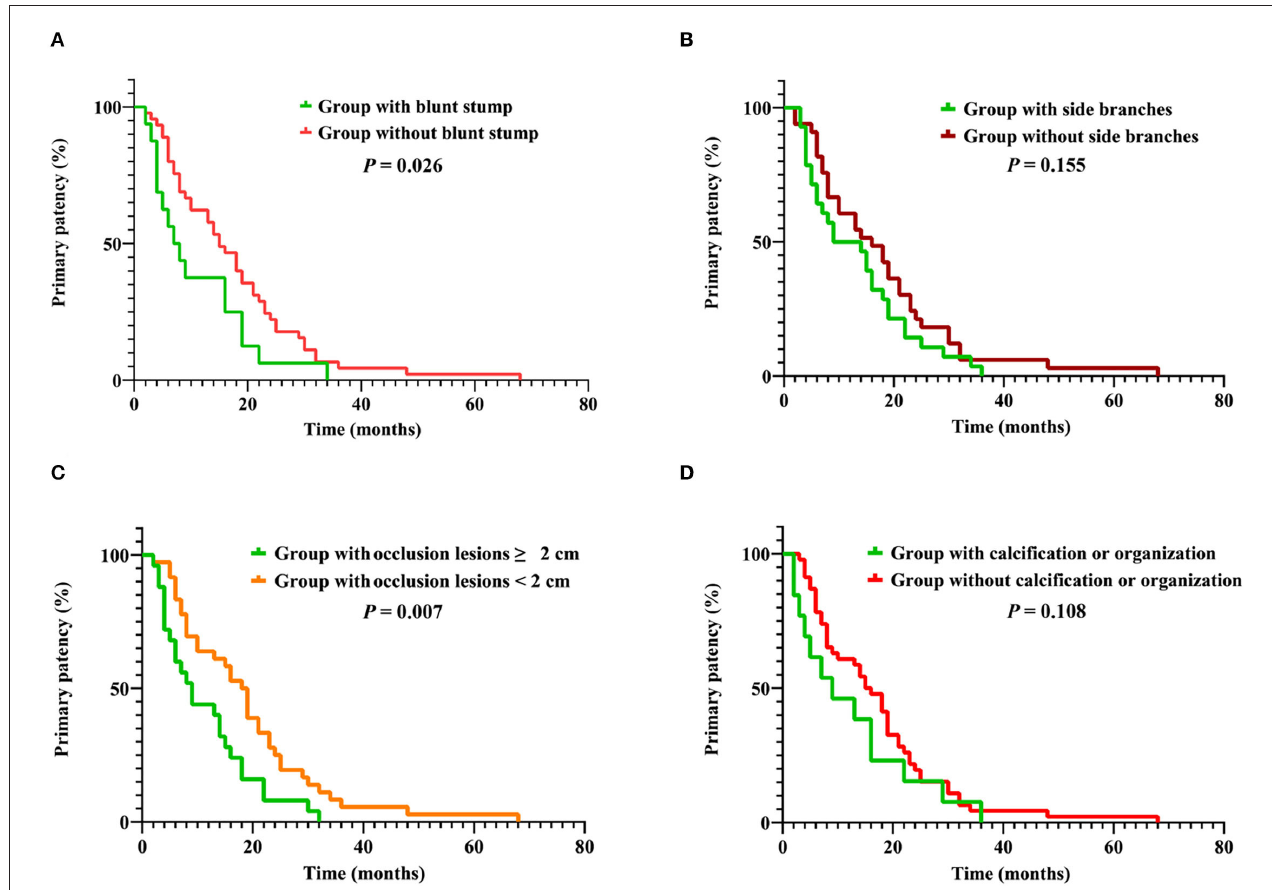
FIGURE 9 | (A) Cumulative primary patency rates between group with blunt stump and group without blunt stump. (B) Cumulative primary patency rates between group with side branches and group without side branches. (C) Cumulative primary patency rates between group with occlusion lesions ≥ 2cm and group with occlusion lesions < 2 cm. (D) Cumulative primary patency rates between group with calcification or organization and group without calcification or